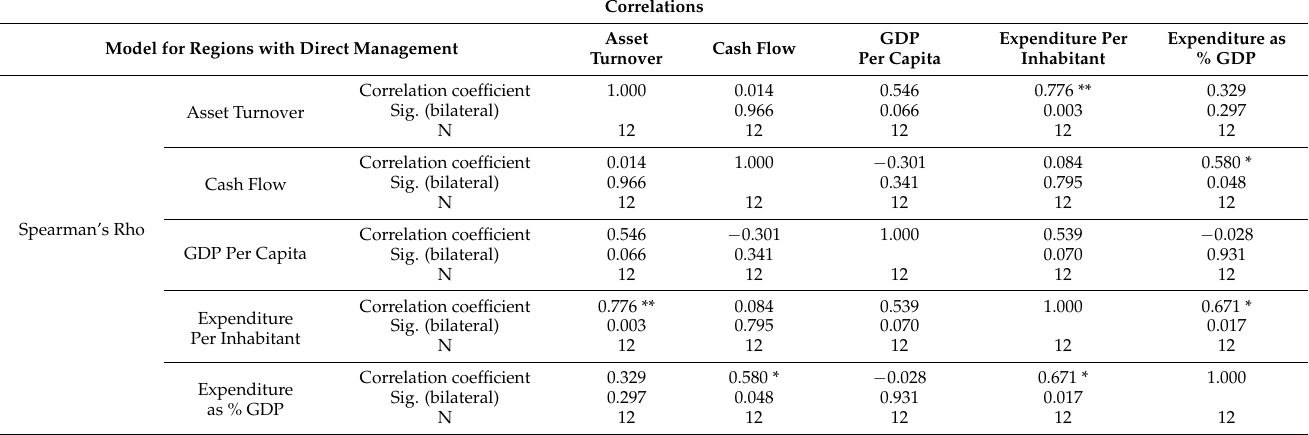
Table 6. Correlation matrix of variables for regions with direct